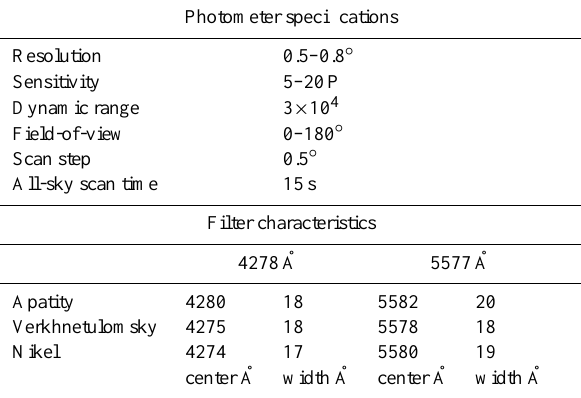
Table 1. Technical specifications of the